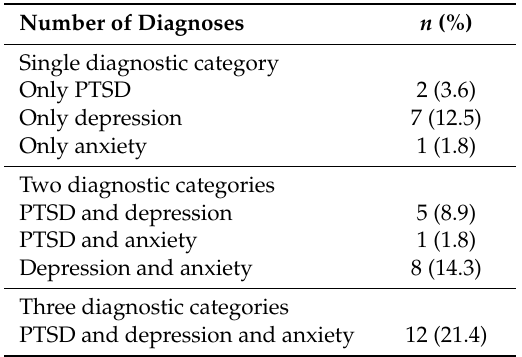
Table 4. Distribution of the number of diagnoses of mental distress.